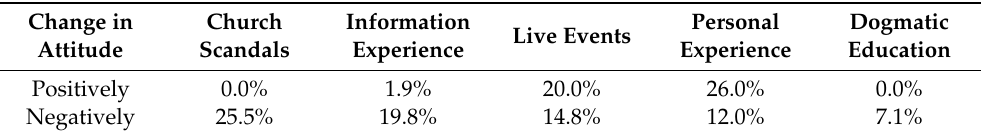
Table 2. Reasons for changing attitudes towards